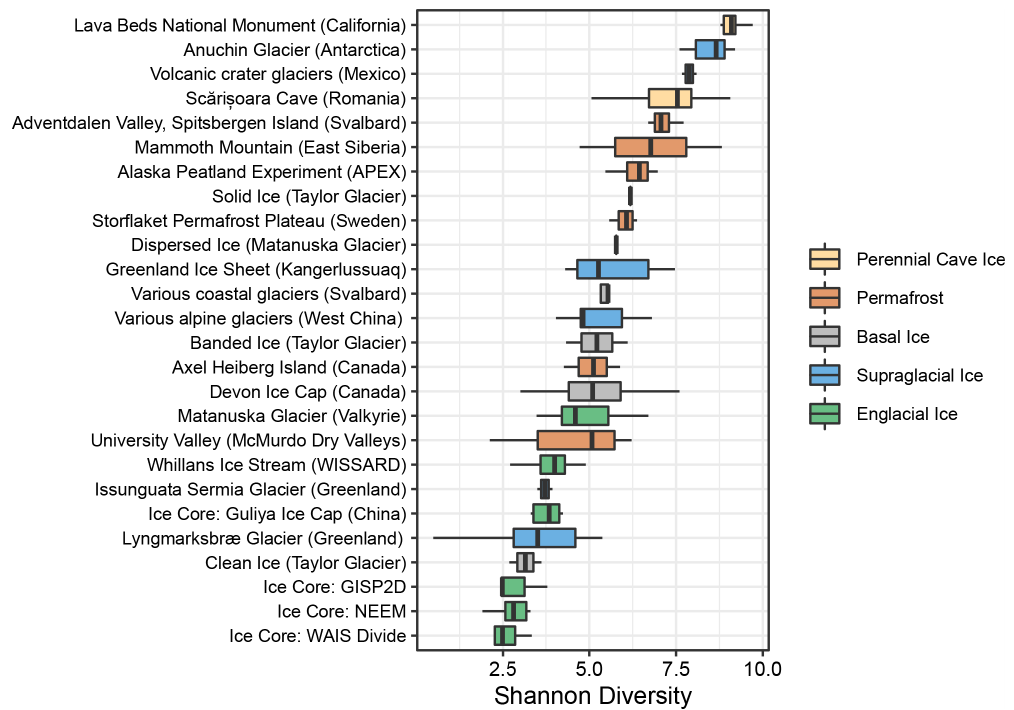
Figure 2. Microbial alpha diversity (Shannon) within various perennially frozen environments.